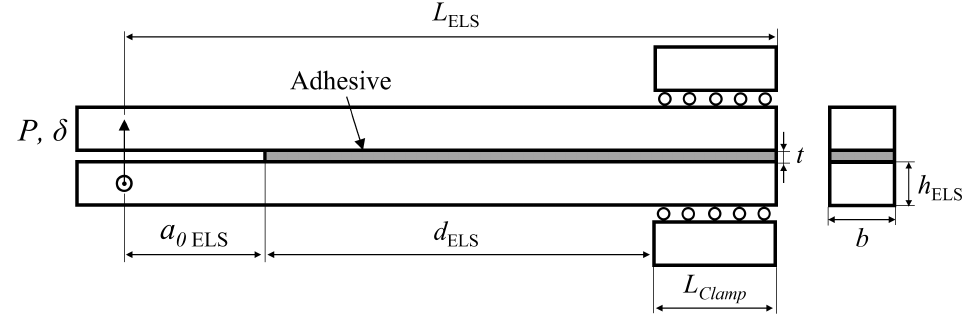
Figure 2. Schematic representation of the ELS specimen and its associated testing